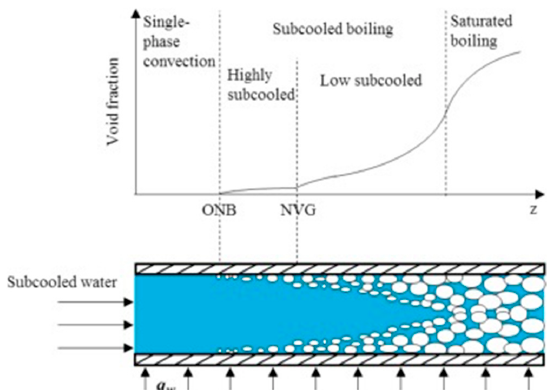
Figure 1. Our current understanding of nucleate flow boiling in nuclear reactor conditions [2]. The bottom panel shows a diagram of the likely distribution of steam bubbles generated at a heated wall in vertical subcooled boiling. In the top panel, the likely distribution of cross-section averaged void fraction is shown. Flow regimes are identified depending on void fraction values: ‘single-phase convection’—zero void fraction; ‘highly subcooled’—bubbles are present only near the wall and condense as soon as released into the flow; ‘low subcooled’—permanence of steam bubbles in a body of partly subcooled liquid; ‘saturated boiling’—the fluid is entirely at or above the saturation temperature and bubbles fill up the pipe cross-section.